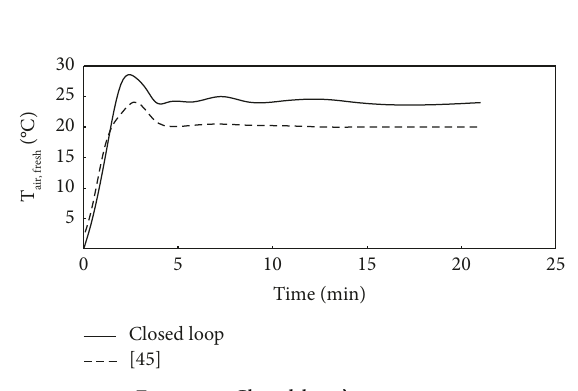
Figure 5: Closed loop’s response. Table 4: Ziegler-Nichols parameters and gains.